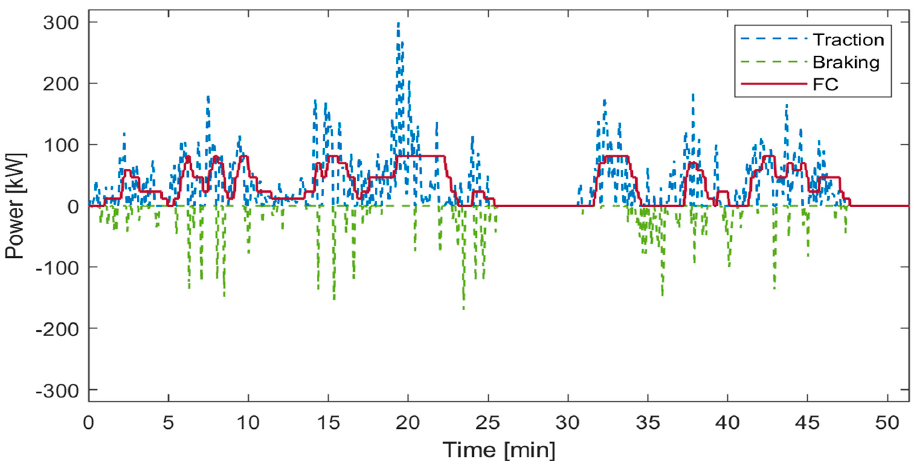
Figure 8. Electric power profiles: traction (blue), regenerative braking (green), and fuel cell (FC) (red).